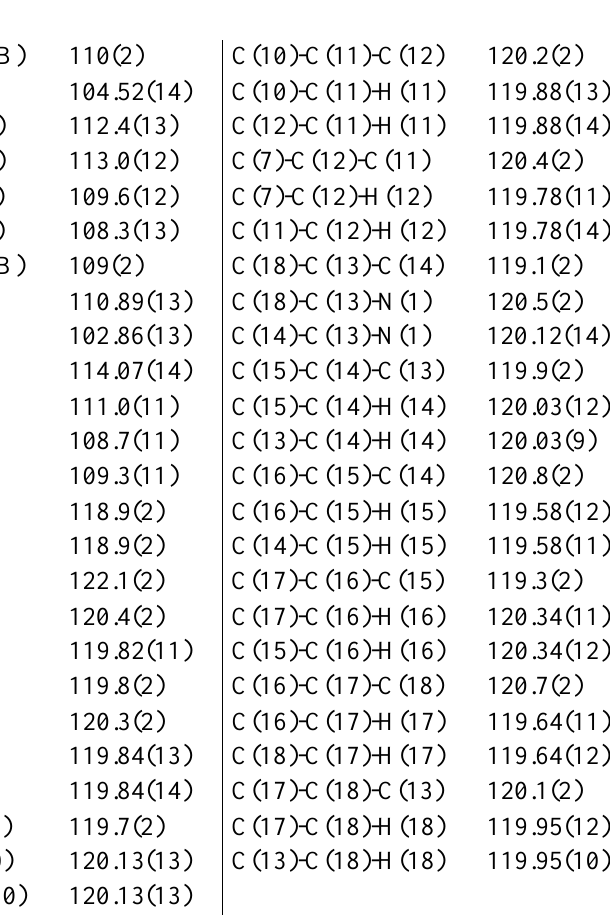
Table 2. Angles [deg] for 3a